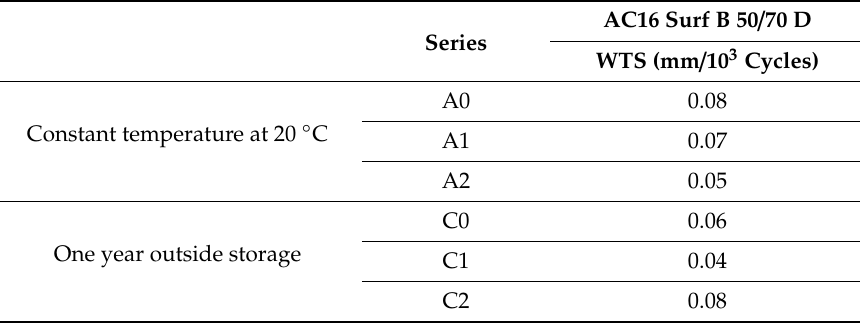
Table 7. Wheel track